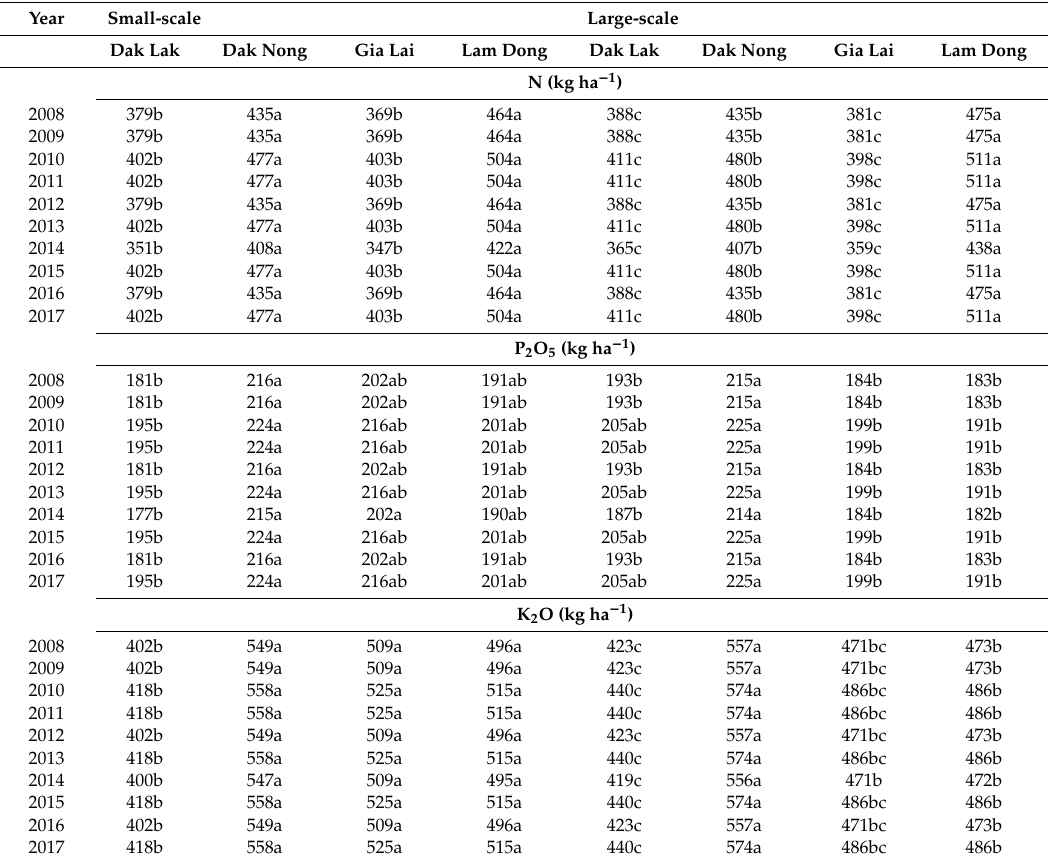
Table 5. Comparison of fertilizer use between provinces in small- and large-scale farms in Vietnam during 2008–2017. For a given farm size group, numbers with similar letter in a given row are not statistically di ff erent ( p >